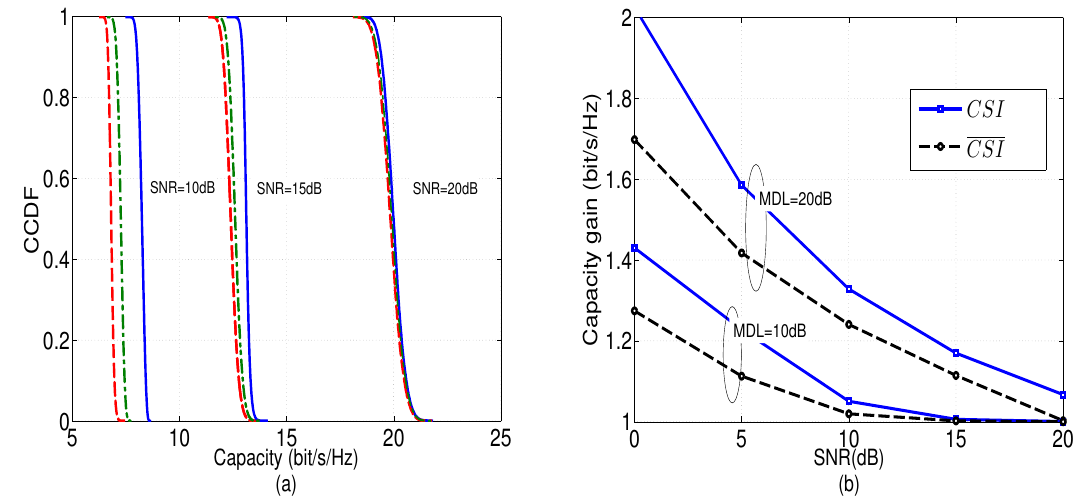
Figure 1. ( a ) Capacity complementary cumulative distribution function (CCDF) with channel state information (CSI) (solid), CSI (dash-dot) and ep (dashed) for SNR = 10, 15, 20 dB and mode-dependent loss (MDL) = 15 dB; ( b ) Capacity gain as a function of SNR for MDL = 10, 20 dB for a 6-mode fiber.